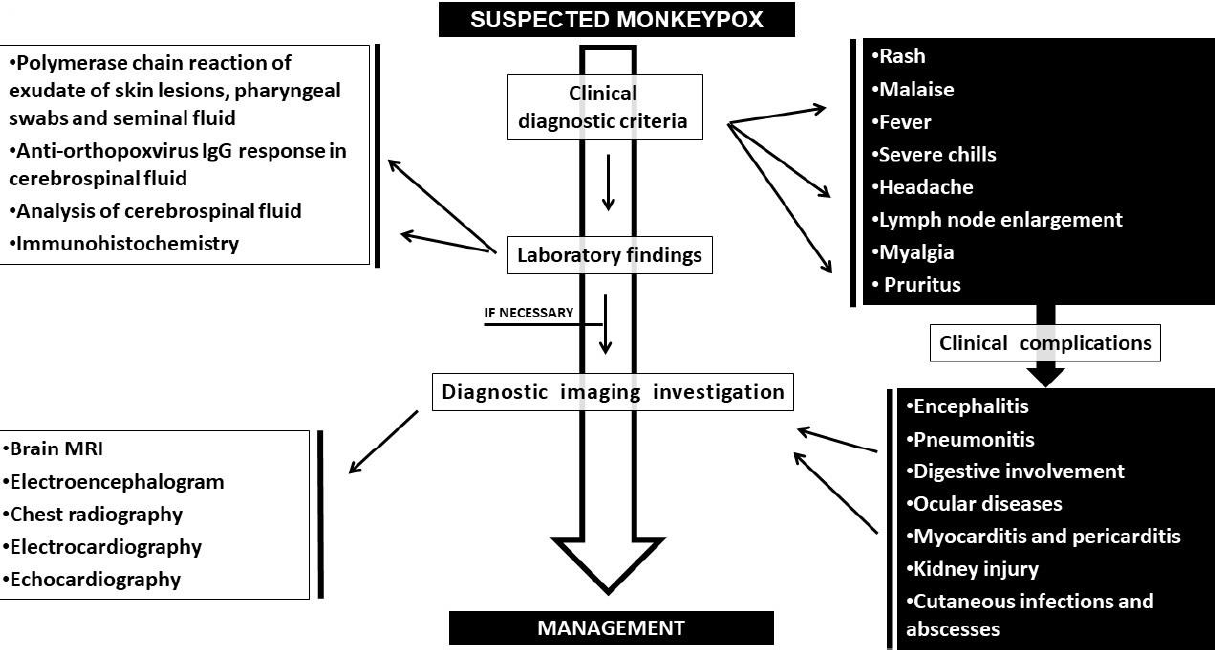
Figure 1. A diagram of clinical signs, diagnostic methods and potential complications of monkeypox disease.